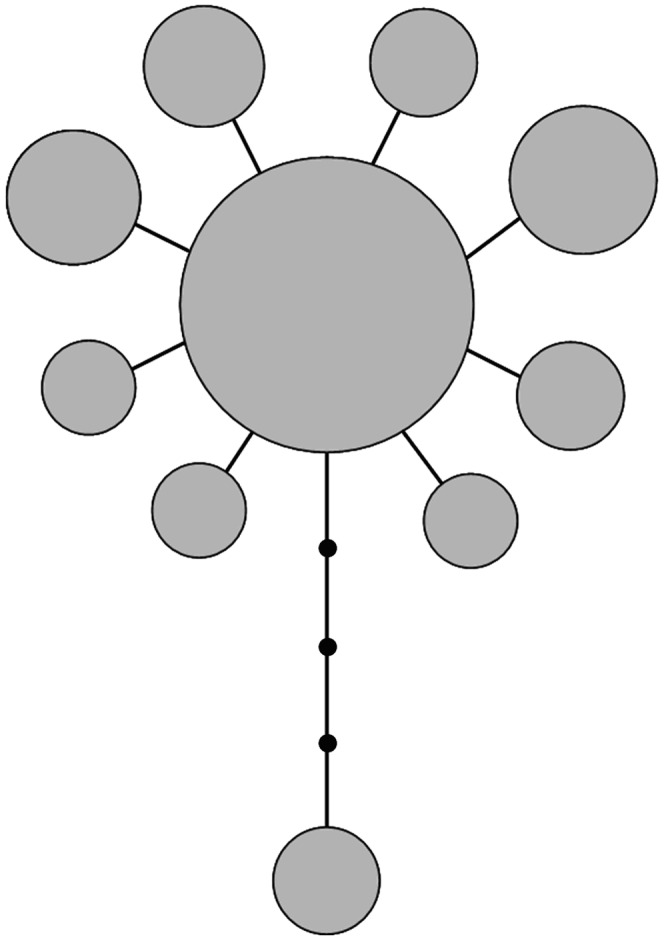
Unrooted haplotype network analysis of A. ardens based on mtDNA CYTB and ND2 sequences.Each circle represents a unique haplotype. The size of the circle indicates the number of individuals of each haplotype. Each black dot represents a single mutational change according to length.